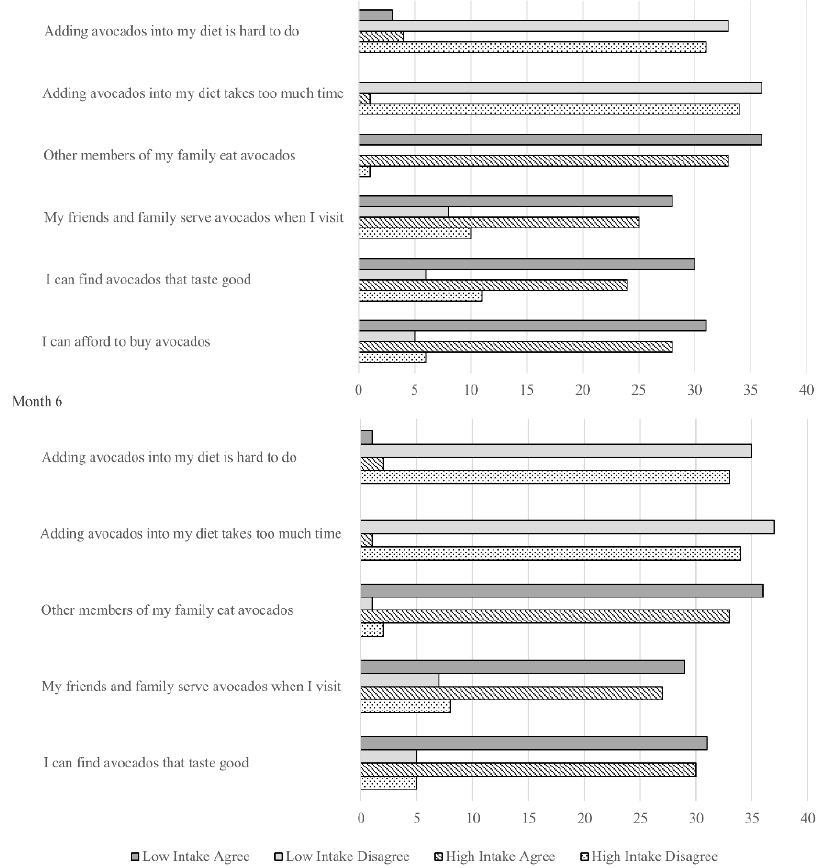
Figure 2. Avocado consumption behavior at baseline and 6 months in the Effects of Avocado Intake on the Nutritional Status of Families Trial. The question: “I can afford to buy avocados” was not applicable at 6 months since the study team supplied families with avocados as part of the intervention. All between-group differences p -values > 0.05.